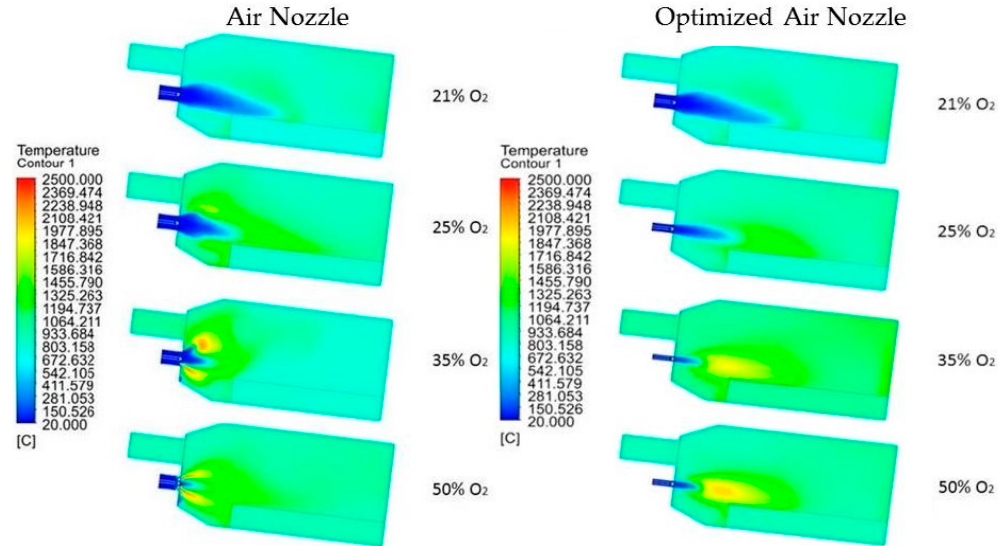
Figure 5. The temperature fields of the experimental device using ordinary air nozzles (on the left ) and optimized air nozzles (on the right ) for various levels of the oxidizer oxygen